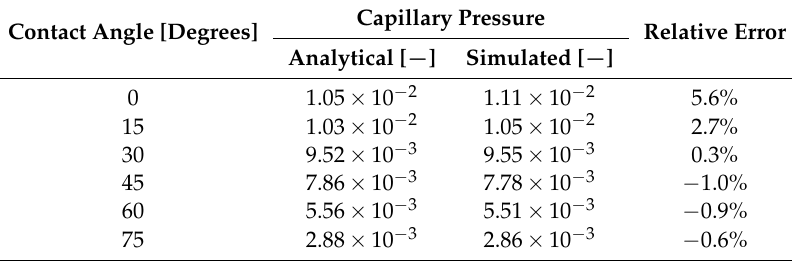
Table 1. Comparison of capillary pressure between analytical and simulated values. The expressions of analytical capillary pressure for a square tube are provided in Øren et al. [35] for when wetting layers were present in the corners ( θ < 45 ◦ ) and in Blunt [4] for when wetting layers were absent ( θ ≥ 45 ◦ ). Contact Angle